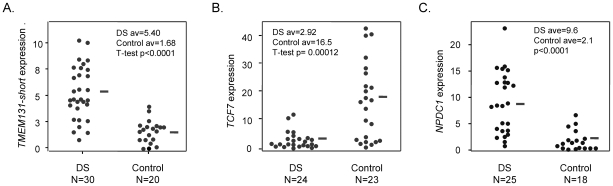
Altered mRNA expression of TMEM131, TCF7, and NPDC1 in DS versus normal PBL.A, Expression of TMEM131 short isoform mRNA measured by Q-PCR. The difference between DS and normal controls is highly significant (T-test, p<0.0001). B, Expression of TCF7 mRNA measured by Q-PCR. The difference between DS and normal controls is highly significant (T-test, p = .00012). C, Expression of NPDC1 mRNA measured by Q-PCR. The difference between DS and normal controls is highly significant (T-test, p<0.0001). The Q-PCR primers are listed in Table S7. The TMEM131 Q-PCR primers are specific for the short mRNA isoform; the TCF7 Q-PCR primers amplify both major isoforms of TCF7 mRNA. The NPDC1 Q-PCR primers amplify all major isoforms.